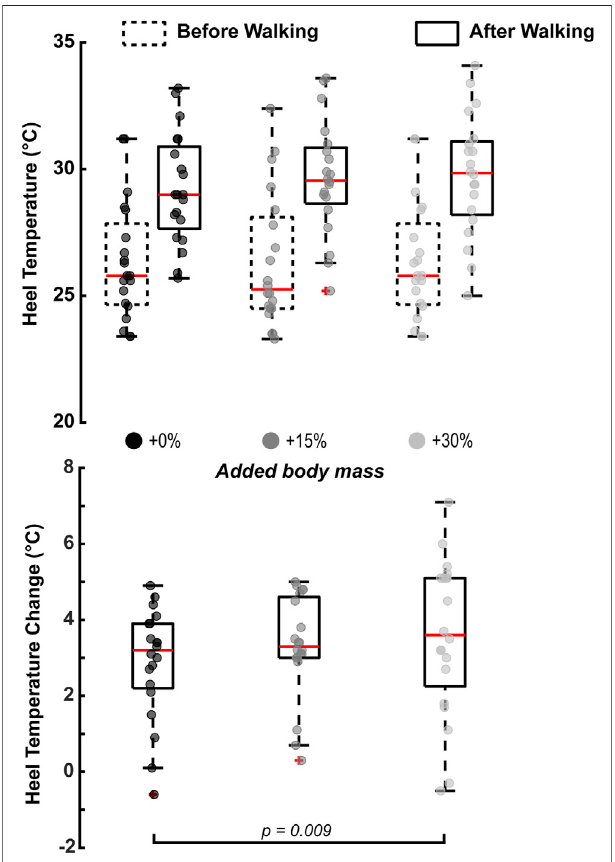
FIGURE 3 | Walking with an additional 30% of body mass signi fi cantly increased theheel ’ s temperature change after 10 min ofbarefoot walking ( p = 0.009).Heel ’ stemperatureincreasedwiththerestoftheconditionbutwasnot statistically signi fi cant. The horizontal square brackets s indicate the adjusted signi fi cant pair-wise comparisons (N = 20). We added jitter to the data on the x-axis only for visualization purposes, using the scatter function in MATLAB R2021a.